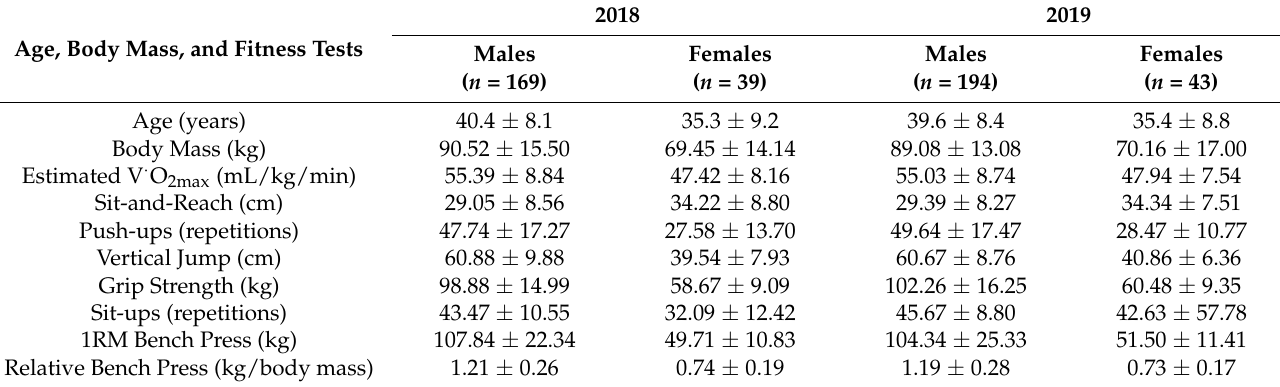
Table 2. Descriptive data (mean ± SD) for age, body mass, and fitness test performance (estimated maximal aerobic capacity (V · O 2max ), sit-and-reach, push-ups, vertical jump, grip strength, sit-ups, one-repetition maximum (1RM) bench press and relative bench press ratio) for male and female police officers from health and wellness programs in 2018 and 2019.